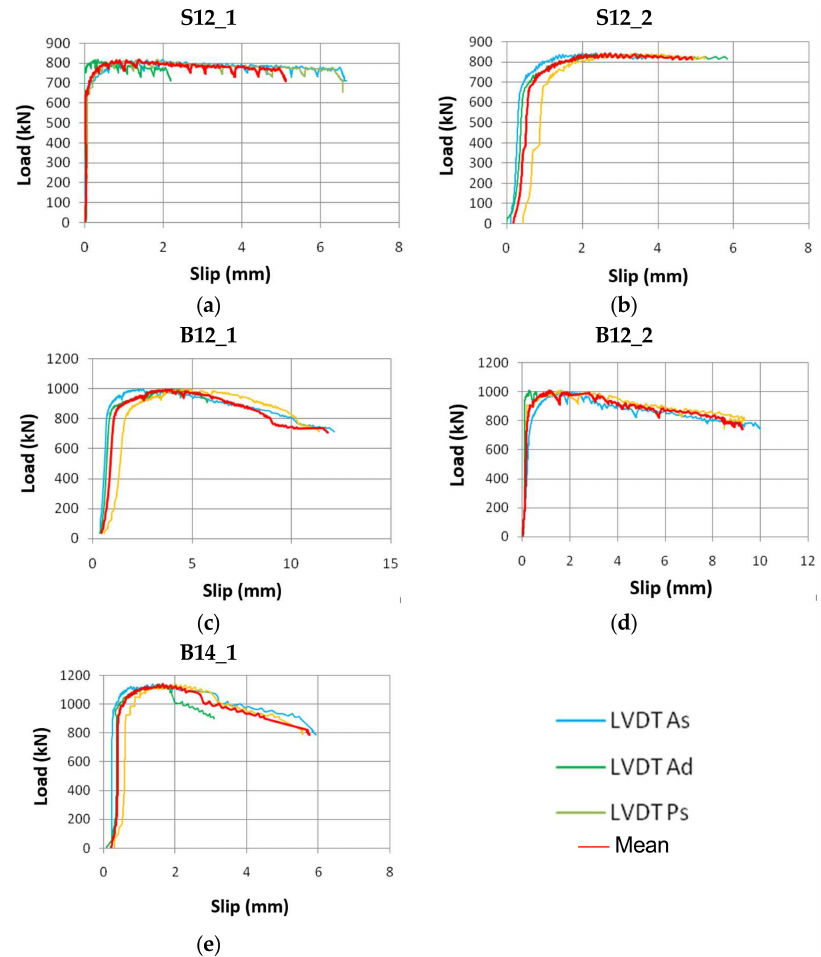
Figure 8. Load-displacement curves in push-out tests, by Aiello [5]: ( a ) specimen S12_1; ( b ) specimen S12_2; ( c ) specimen B12_1; ( d ) specimen B12_2; ( e ) specimen